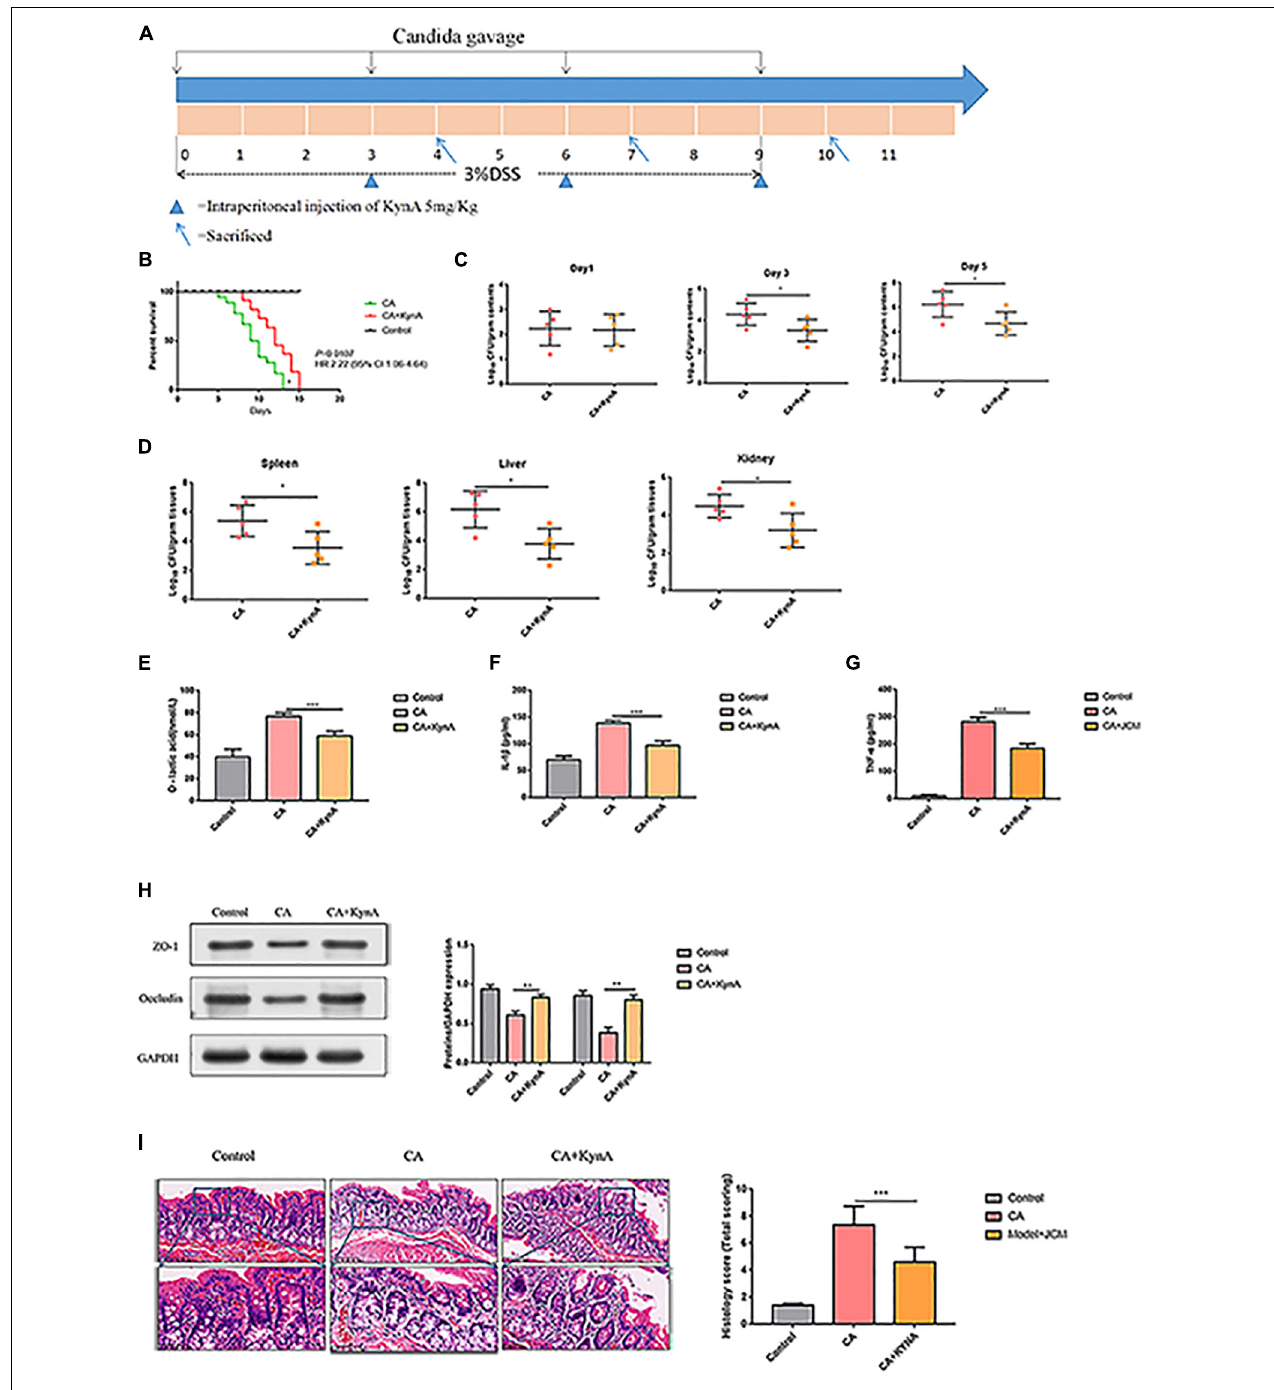
FIGURE 4 | Kynurenic acid alleviates intestinal injury caused by invasive C. albicans infection. (A) Experimental design including KynA administration and Candida gavage. (B) Mice infected with C. albicans exhibited higher mortality than mice treated with KynA. (C) KynA treatment decreased the colonization of intestinal C. albicans . Fungal load in feces collected from untreated and KynA groups at 1, 3, and 5 days after infection. (D) Fungal load in kidneys, spleen, and liver samples from euthanized mice collected immediately in the KynA-treated groups and 10 days post-infection in the untreated groups. (E–G) The levels of D-lactic acid, IL-1 β , and TNF- α were significantly decreased in the CA+KynA group compared to those of the CA group ( P < 0.05). (H) Expression of ZO-1 and occludin in the intestinal epithelial cells of the CA+KynA group was significantly higher than in the CA group. (I) Chiu’s pathological scoring system revealed that mice from the CA+ KynA group had less intestinal mucosal damage than the mice in the CA group. Statistical significance was evaluated using the Mann–Whitney U test. P- values < 0.05 (*) or < 0.01 (**) were considered statistically significant. CA, Candida albicans infection; KynA, Kynurenic acid.